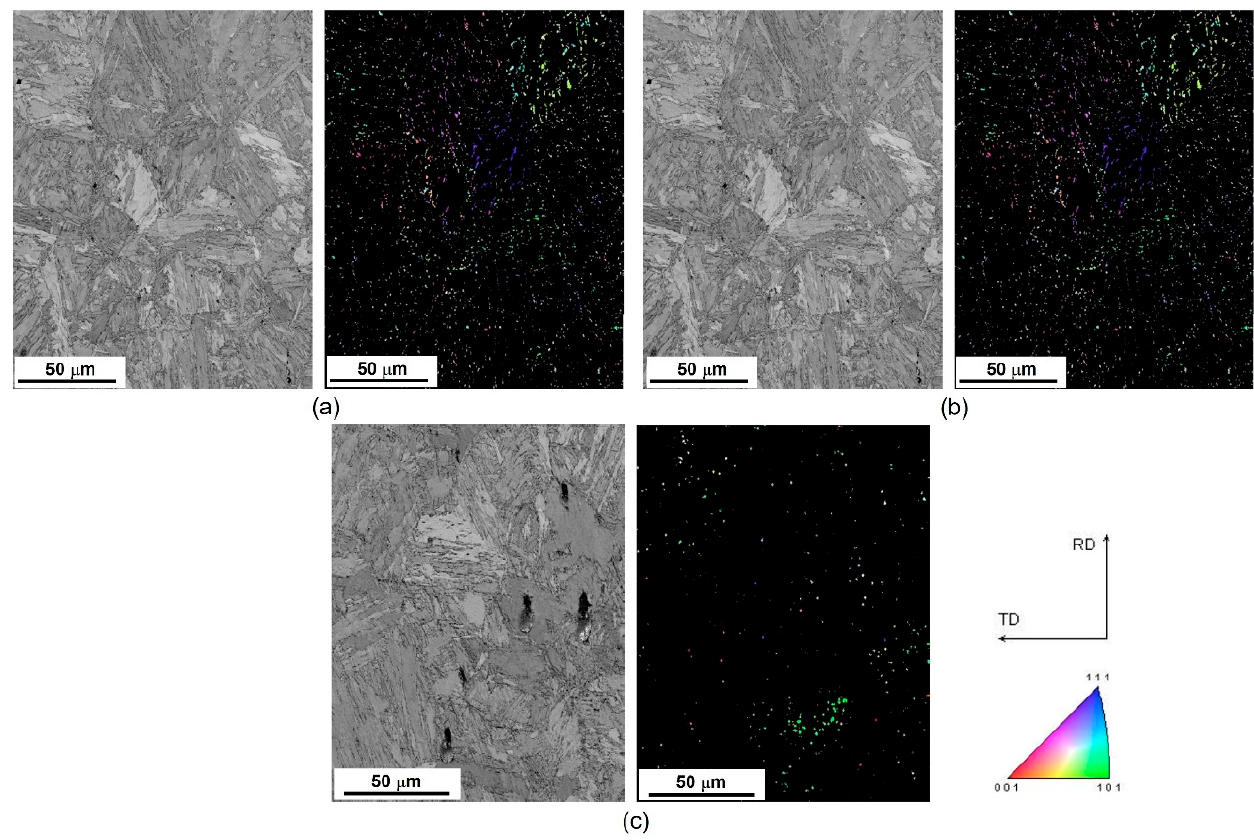
Figure 11. OIM analysis of austenite: ( a ) M330-300 ( b ) M390-300 y ( c ) M450-300.